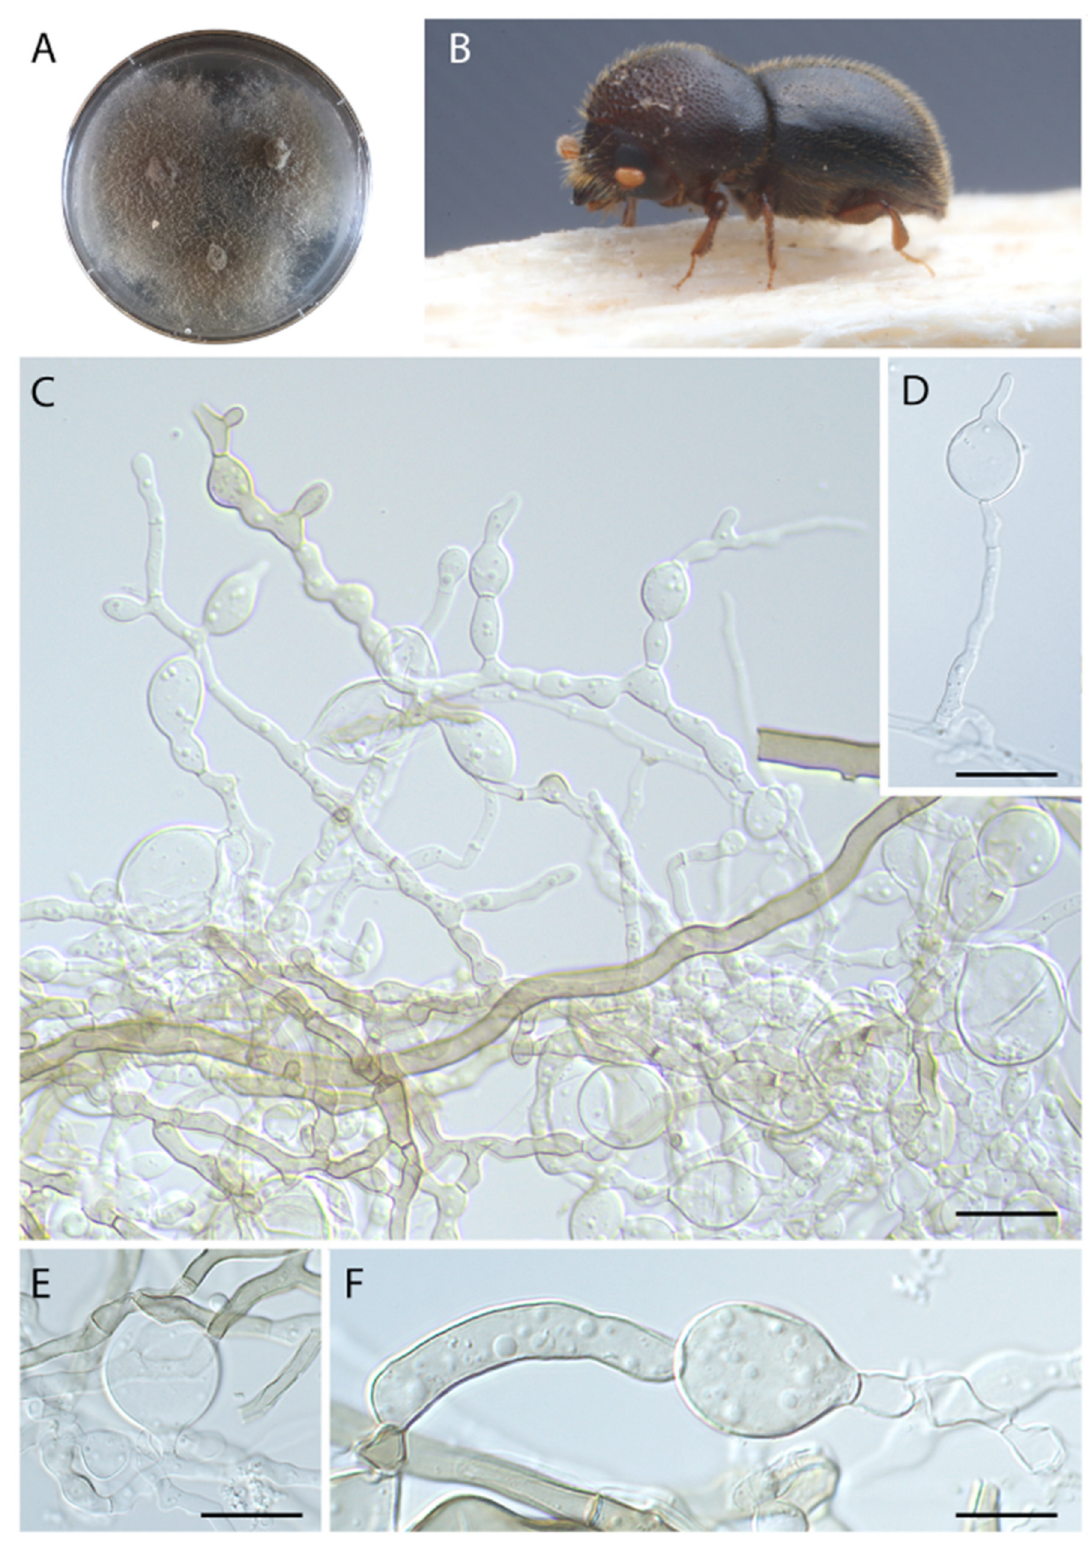
Figure 4. Harringtonia ambrosioides in pure culture on PDA. ( A ) Colony growth after 3 weeks at 25 ◦ C. ( B ) Beetle vector, Dryocoetoides capucinus . ( C ) Aspect of vegetative hyphae bearing multiple ambrosial cells (vesicles). ( D ) Close-up of a terminal vesicle. ( E ) Vesicle produced laterally on the main hyphae. ( F ) Enlarged hyphae. Scale bars: ( C ) = 15 µ m, ( D ) = 10 µ m, ( E ) = 20 µ m, ( F ) = 10 µ